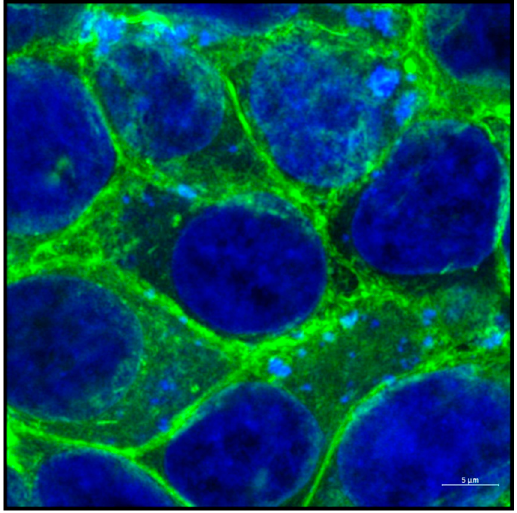
Figure 3. Actin cytoskeleton of a cell. Immunofluorescent image of HeLa cells showing actin (Phalloidin 488) surrounding a group of cells. Nucleus is shown in blue. Image was taken using airy scan mode in Zeiss 800 confocal microscope using 63× objective. Scale bar = 5 µm .